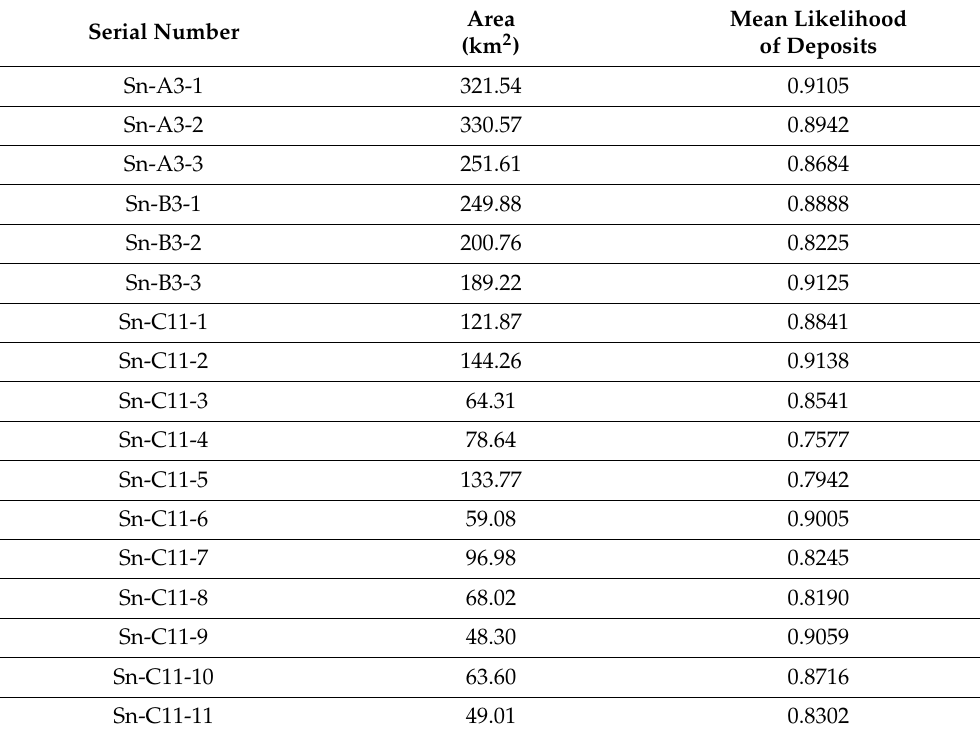
Table 10. Attributes of Sn prospective areas.